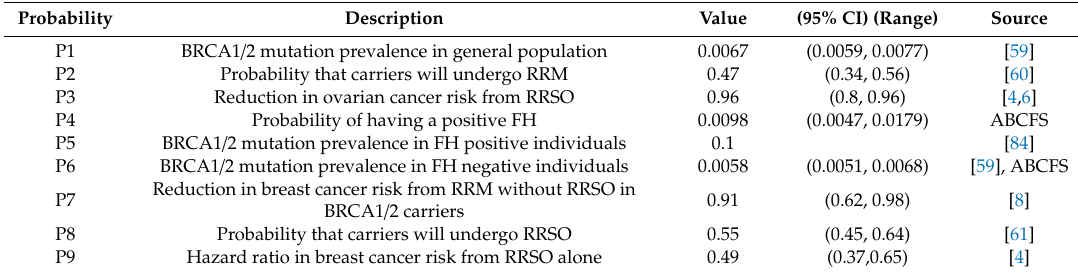
Table A1. Probability